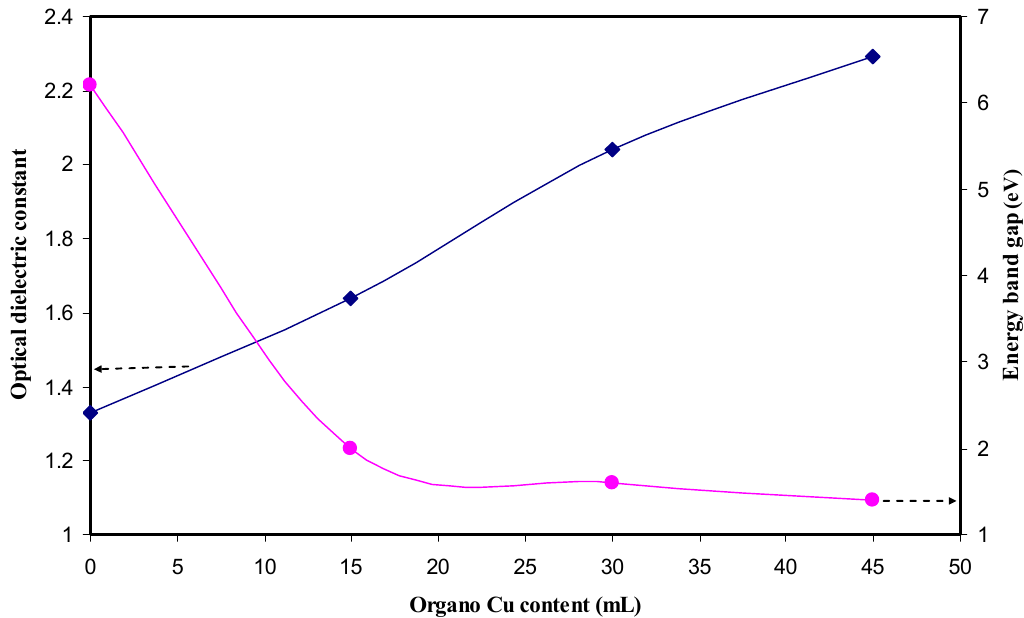
Figure 11. Dielectric constant and energy band gap versus organocopper content.